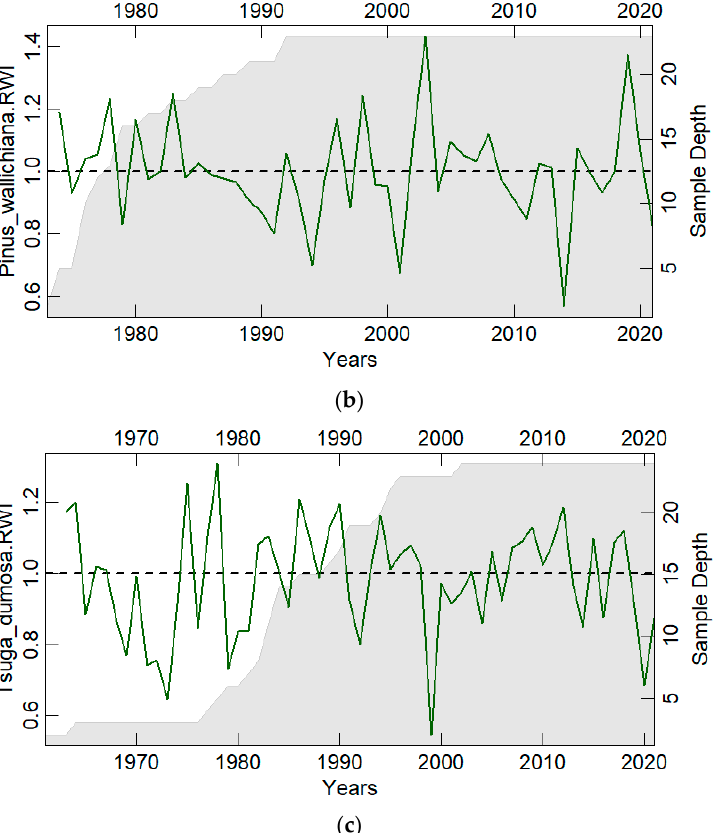
Figure 2. Residual chronology of Abies pindrow ( a ), Pinus wallichiana ( b ) and Tsuga dumosa ( c ) from Jiri, Nepal. Grey shaded area indicates sample depth.